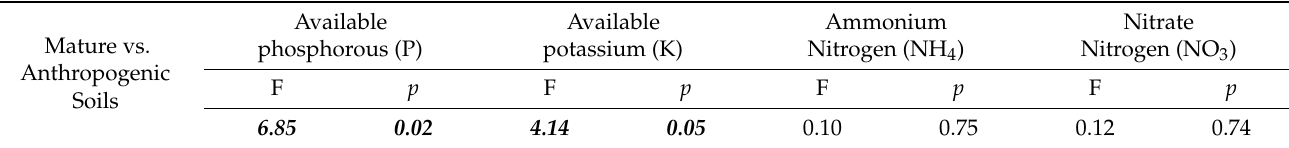
Table 4. Results of MANOVA analysis of nutrients content. Mature vs.